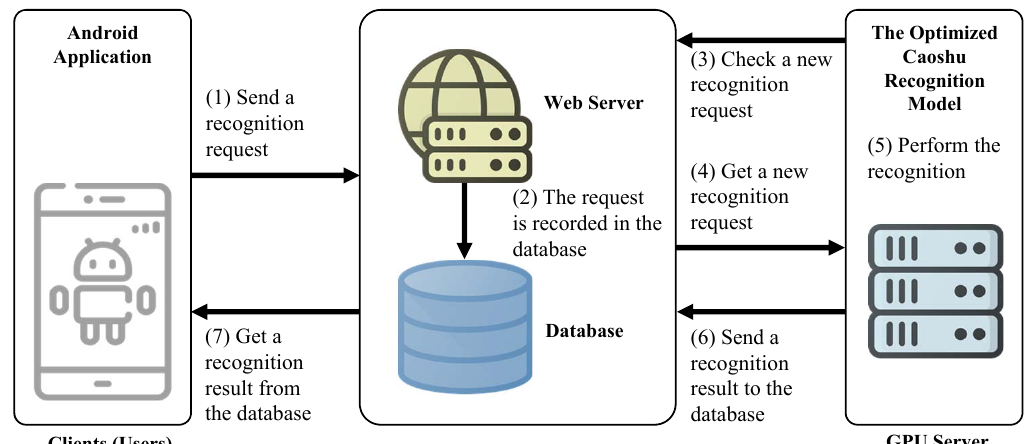
Figure 10. The service flow of the proposed online Caoshu recognition